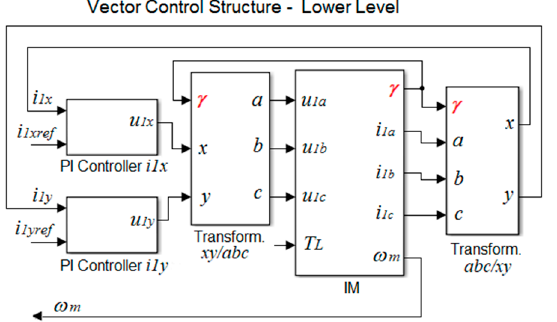
Figure 10. The lower level of the vector control structure, where γ is the actual position of the rotor flux vector.